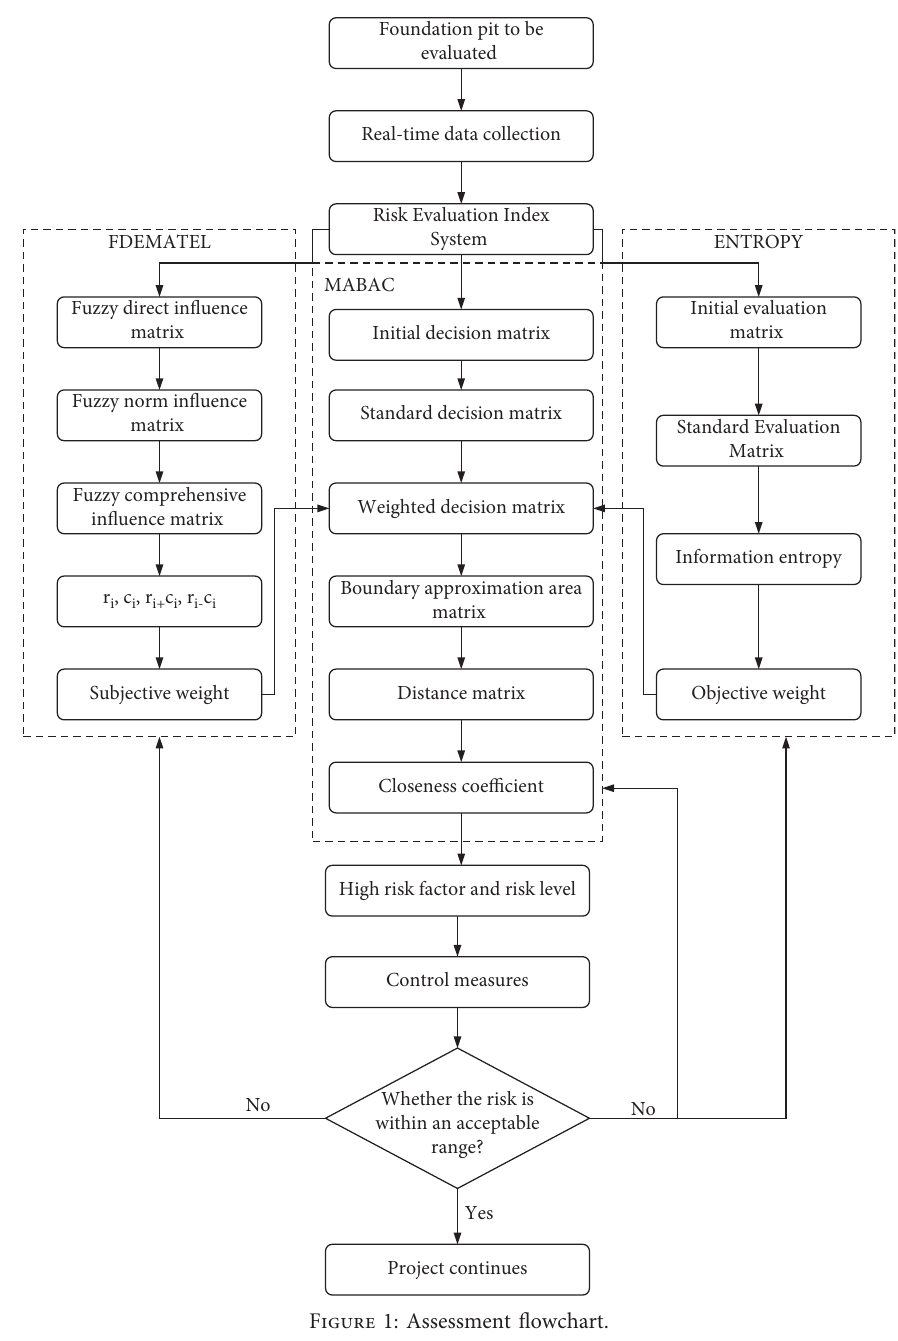
Figure 1: Assessment